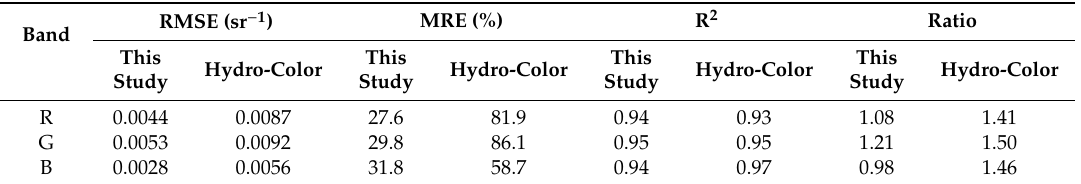
Table 2. Accuracy evaluation of water leaving reflectance derived from digital images acquired at